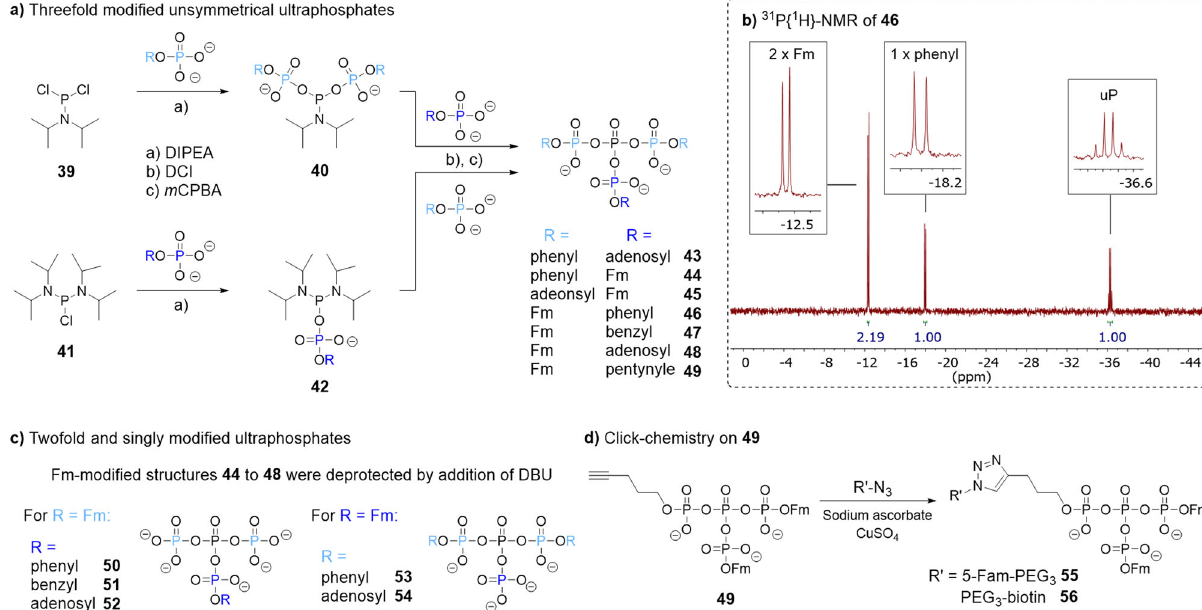
Fig. 3 Unsymmetrical ultraphosphates. For the discussion of yields see Supplementary Methods 12.2. a Syntheses of threefold modi fi ed unsymmetrical ultraphosphates using either a chloro phosphormono- or diamidite. b 31 P{ 1 H}-NMR spectrum of unsymmetrically modi fi ed ultraphosphate 46 . c Twofold and singly modi fi ed ultraphosphates by deprotection of Fm-modi fi ed, unsymmetrical ultraphosphates using DBU. d Application of click-chemistry on ultraphosphate 49